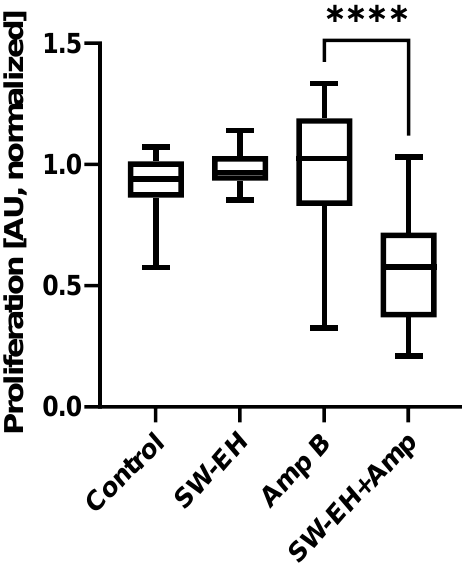
Figure 6. Microscopic images at 10× magnification showing hyphal width: qualitative comparison of biofilm grown on plastic ( left ) and biofilm grown on fibrin ( right ).